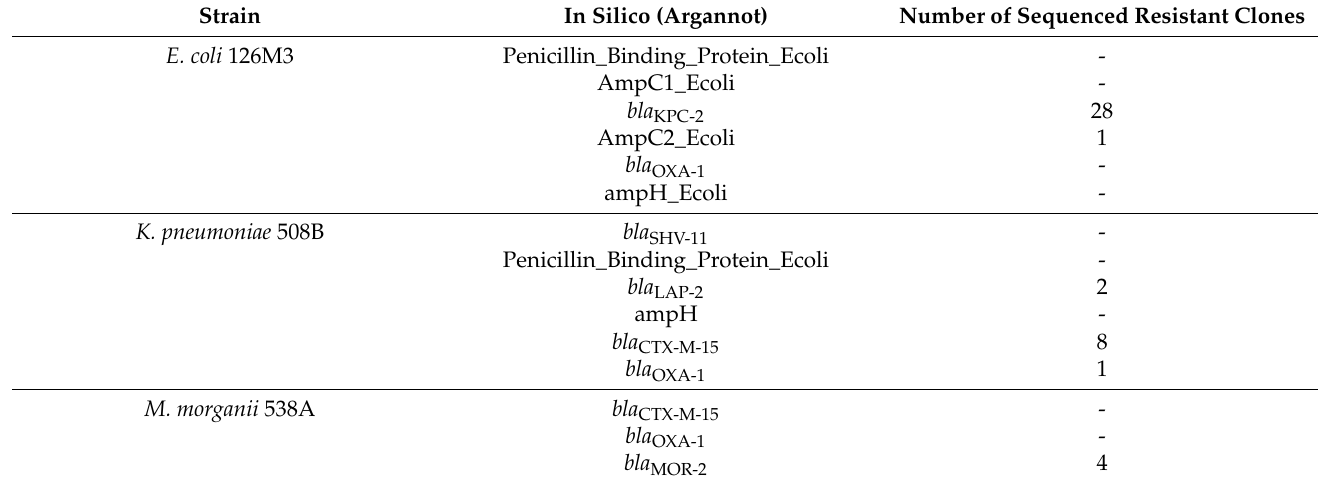
Table 2. Comparison of ARG identification using in silico and functional approaches.